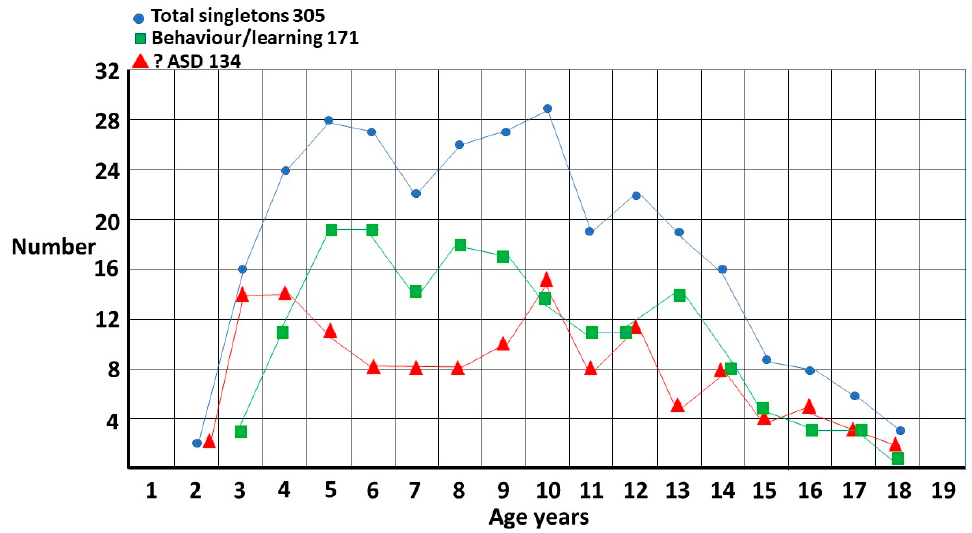
Figure 2. Singleton distribution by referral question. ?ASD and behaviour/learning now referenced in text twice, before and after figure.